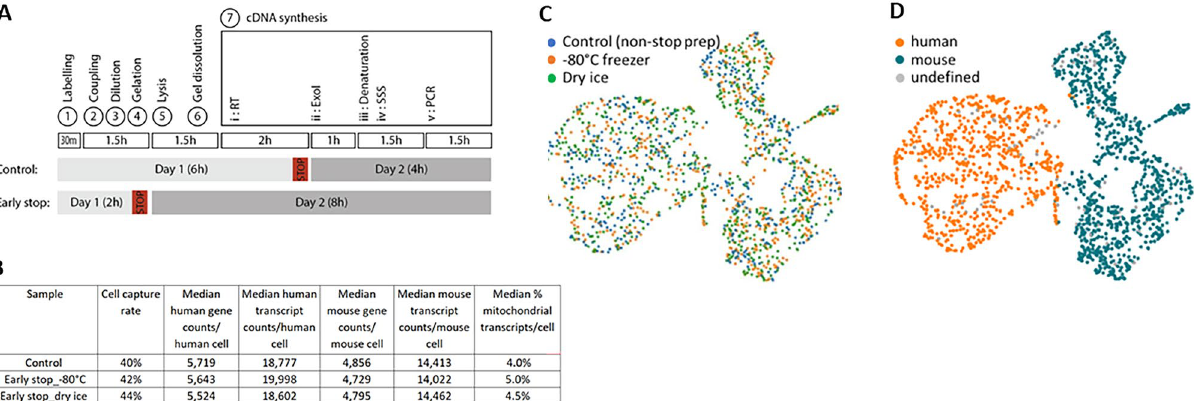
Figure 5. Freezing samples at an early stopping point during RevGel-seq protocol does not modify scRNA preparation performances. ( A ) Schematic representation of the timing differences between the “Control” and “Early stop” samples (see “Methods” for specific steps). “Control” samples were obtained by freezing the RT reaction mixture at − 20 °C overnight, while “Early stop 80 °C” and “Early stop dry ice” samples were obtained by freezing (either at − 80 °C or in dry ice, respectively) immediately after applying lysis buffer to the hydrogel. The RevGel-seq protocol was resumed on a subsequent day for all samples. ( B ) Comparison of performance indicators between the tested conditions (average of 3 PCR tubes for each condition). Gene and transcript counts per analyzed cell at 50,000 raw reads per cell with raw read downsampling. ( C , D ) Projection of scRNA- seq data on 2D (UMAP) of the pooled samples (pool of data from 1 PCR tube for all 3 conditions), shown per condition ( C ) and per determined cell species ( D ). (“undefined” corresponds to cells with a cell barcode purity lower than 95%; see Methods section “Pre-processing pipeline”, iii). With respect to cell capture yields, obtained cell species proportions were as follows: human 45.8%, mouse 49.9%, undefined 4.3% (Control sample); human 48.6%, mouse 52.5%, undefined 3.9% (Early stop dry ice); and human 46.2%, mouse 48.4%, undefined 5.4% (Early stop − 80